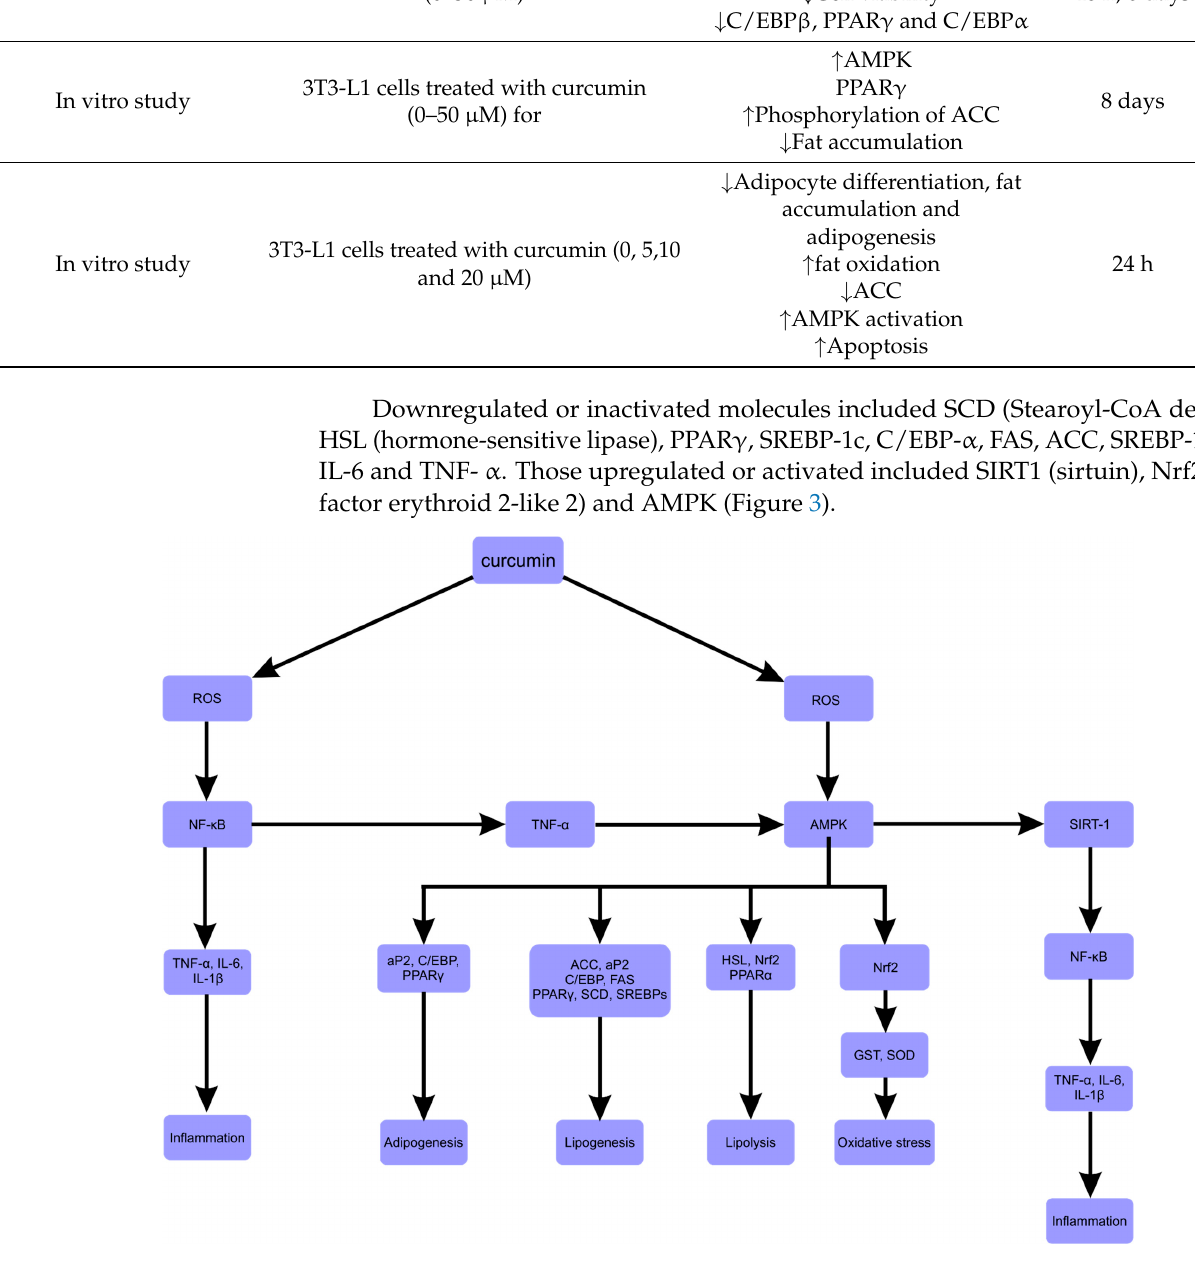
Figure 3. Potential anti-obesity mechanisms of curcumin [125]. An explanation of the abbreviations can be found at the end of the review. Adapted with permission from ref. [125]. Copyright 2021 Ohishi, Fukutomi, Shoji, Goto and